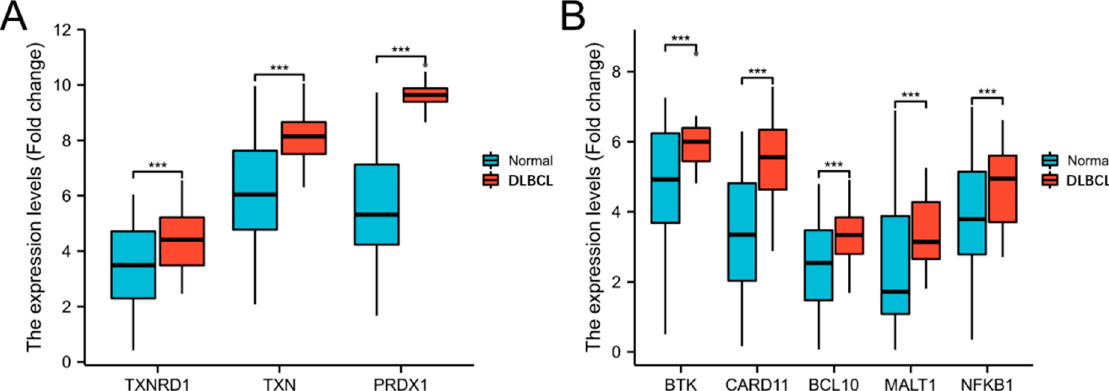
Figure 1. Trx system and BCR signalling pathway-related gene expression in DLBCL and healthy samples. ( A , B ), mRNA expression in diffuse large B-cell lymphoma (DLBCL) patients ( n = 47) and healthy samples ( n = 444) was analysed. The significance levels are marked as *** p < 0.001. Table 2. Expression levels of the Trx system and BCR signalling pathway-related proteins in NHL and healthy samples retrieved from the Human Protein